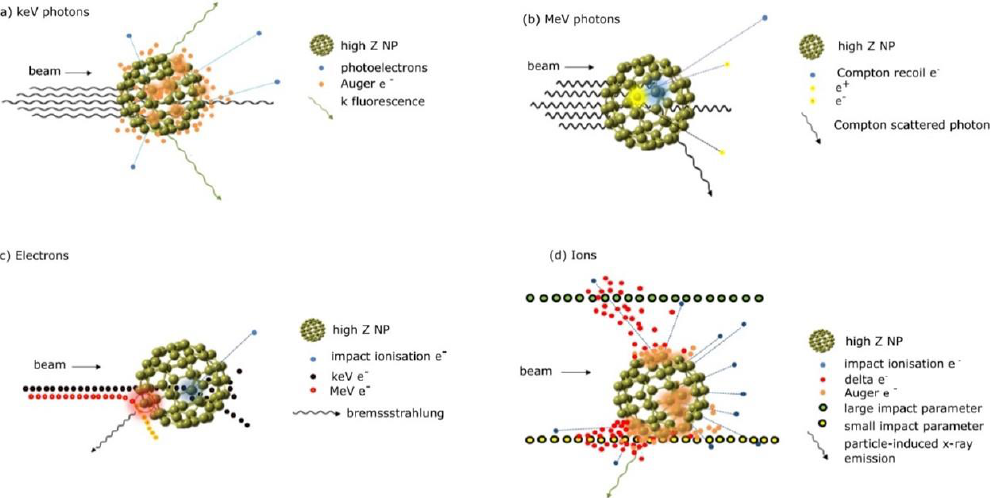
Figure 3. Mechanisms of interaction of high-Z NPs with ( a ) keV photons, ( b ) MeV photons, ( c ) elec- trons, and ( d ) ions. Reprinted with permission from Ref. [82]. Copyright 2022, Creative Commons.